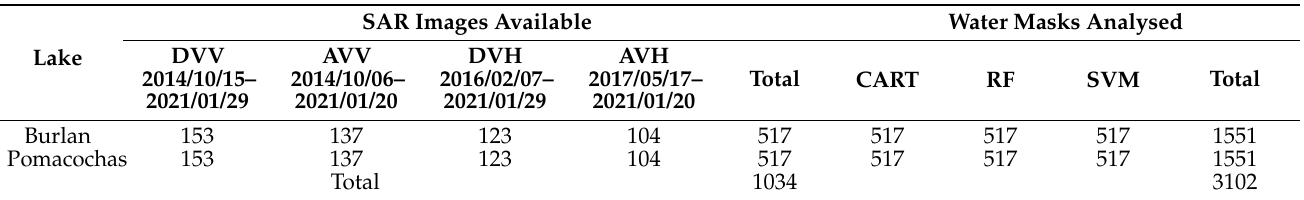
Table 1. Number of SAR images used to generate the water masks of Burlan and Pomacochas Lakes using CART, RF, and SVM. SAR Images Available